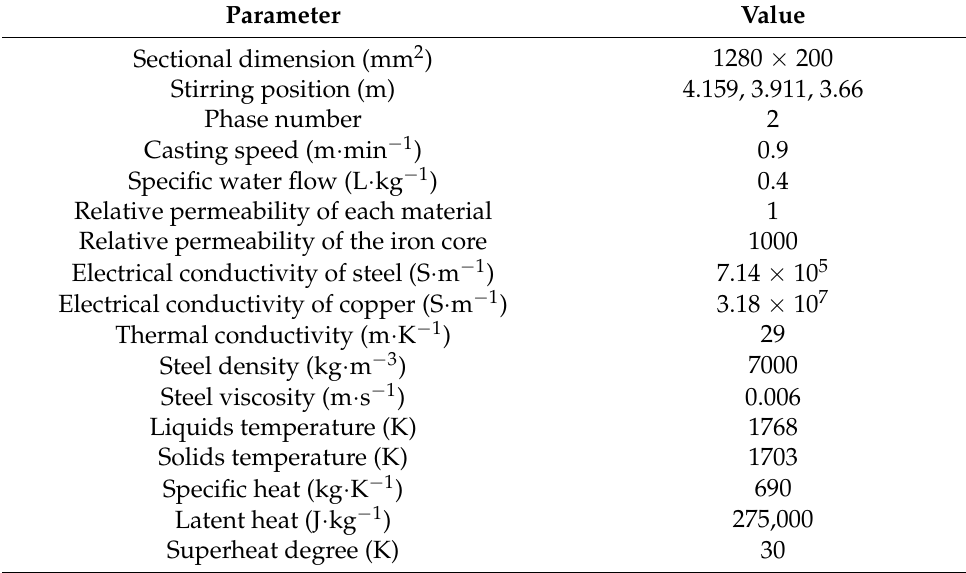
Figure 1. Roller electromagnetic stirring (R-EMS): ( a ) Structure diagram; ( b ) installation location diagram (units: mm). Table 1. Geometrical and operational parameters of the cast and thermophysical properties of Fe–17 wt% Cr–0.6 wt% Ni steel.